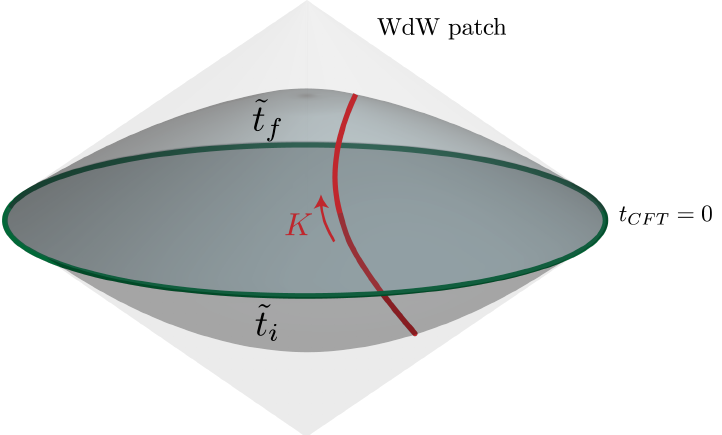
Figure 8. A Wheeler-de Witt patch in AdS corresponding to the CFT state at a fixed boundary time t = 0 . Our observer (red worldline) travels between the two Cauchy slices of the WdW CFT patch labelled by ˜ t . The proper length of the worldline can be computed via eq. (1.1), even though i,f no dynamical evolution of the full quantum system takes